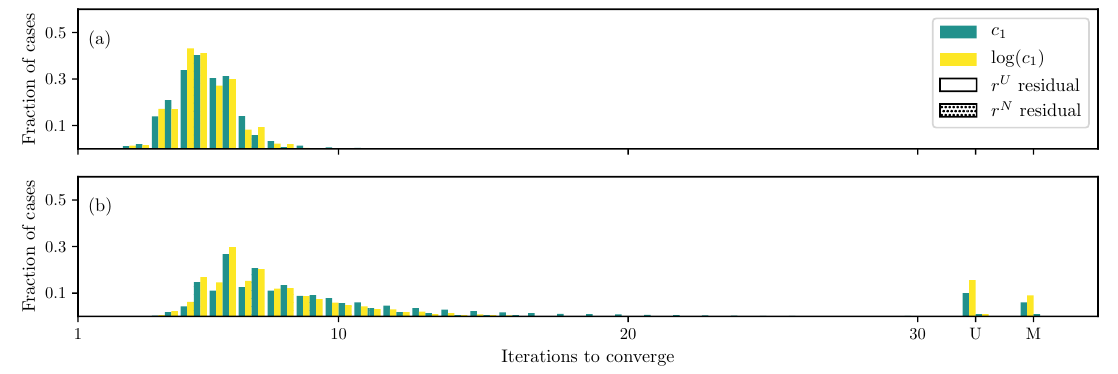
Figure 11. Iterations required using different formulations for ( a ) the GOH model DC case when all parameters except fiber angle θ and dispersion c 3 are unknown, ( b ) the Lee–Sacks model when all parameters except the fiber angle θ and dispersion c 4 are